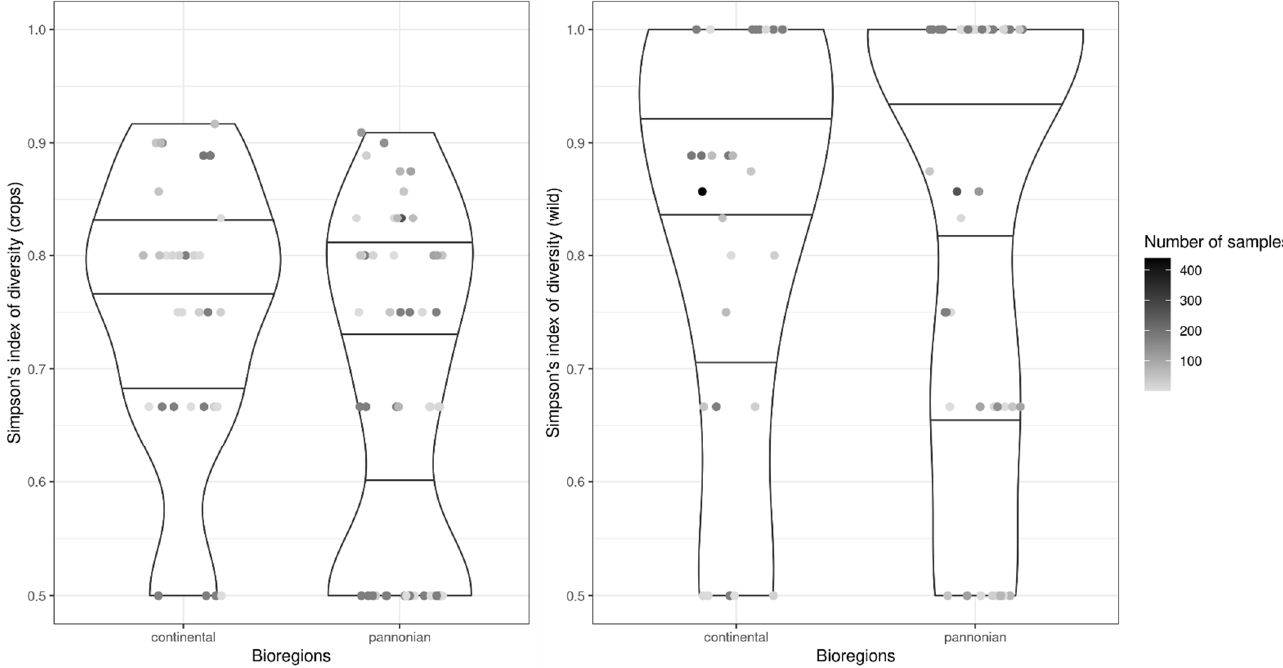
Figure 6. Simpson’s indices of diversity (1-D) for crop assemblages and wild species by bioregion.